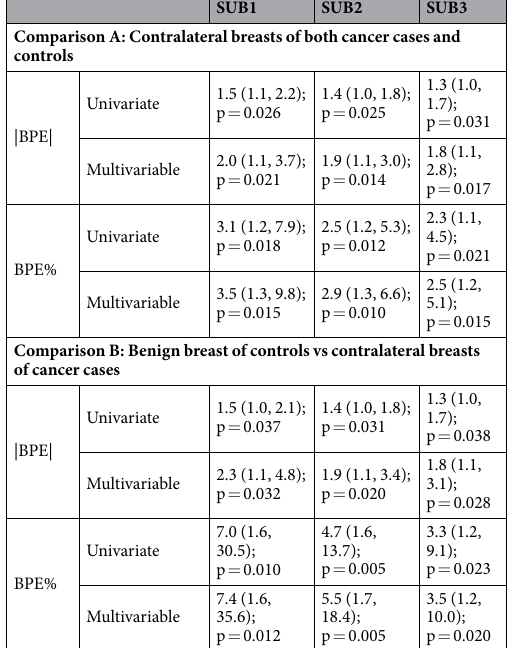
Table 3. Breast cancer odd ratios for BPE quantified separately from three SUBs for 51 women with a cancer diagnosis and 51 controls with a biopsy-proven benign finding. |BPE| = Volume of background parenchymal enhancement, with odds ratio for 200 cm 3 difference. BPE% = Percentage of background parenchymal enhancement volume (|BPE|) relative to breast volume, with odds ratio for 20 percentage point difference. SUB1, SUB2, SUB3 = Subtraction sequence (i.e., post-contrast – pre-contrast) for each of first, second, and third post-contrast sequences, respectively. Odds ratios, 95% confidence intervals, and p-values are shown for univariate conditional logistic regression, and for multivariable models controlling for menopausal status, family history of breast cancer, BI-RADS-based mammographic density, |FGT|, and FGT%. The p-values indicate statistical significance of the tested BPE measure (i.e., |BPE| or BPE%) in the logistic regression modeling. The p-values shown in the table were prior to the multiple test adjustment by FDR. After applying the adjustment for 6 comparisons at the 0.05 overall FDR, the 6 adjusted p-values remained statistically significant (all p < 0.031 for the 6 univariate analyses in Comparison A; all p < 0.021 for the 6 multivariable analyses in Comparison A; all p < 0.038 for the 6 univariate analyses in Comparison B; all p < 0.032 for the 6 multivariable analyses in Comparison B).